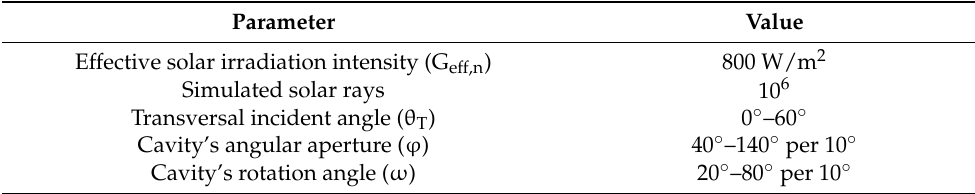
Table 4. Optical simulation